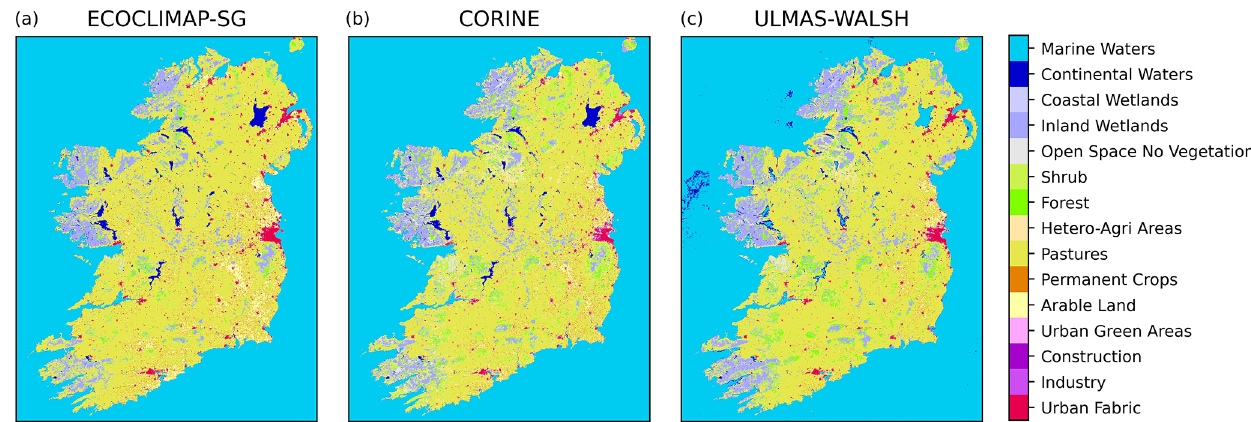
Figure 9. Land-cover maps of Ireland for ECO-SG, CORINE and the UW map. Pixel-wise, ECO-SG was found to be 82.4% similar to CORINE. The UW map was found to be 86.4% similar to